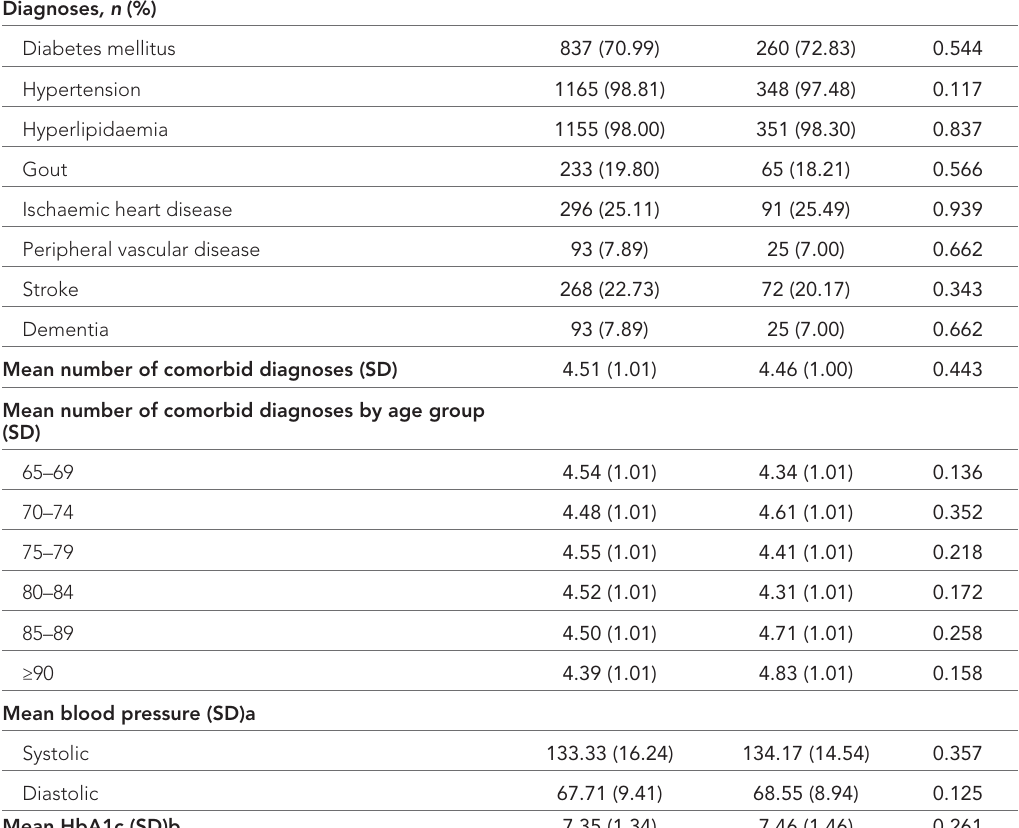
Table 3 Comparison of patient comorbidities between non- referral and referral groups Non- referral group Referral group P